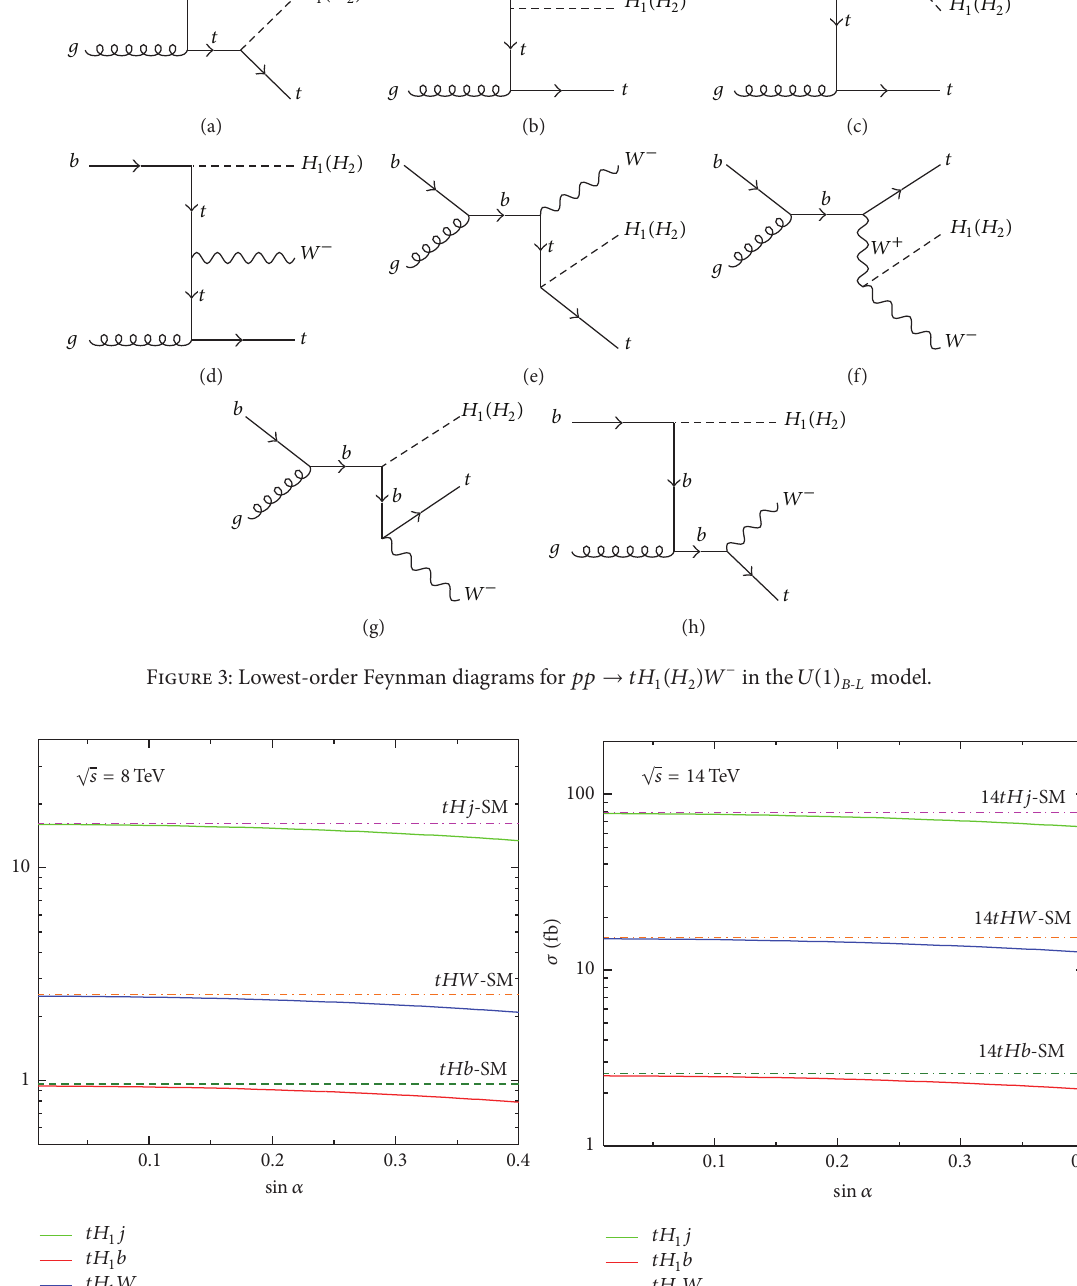
, 𝜎 𝑡𝐻 , 𝜎 𝑡𝐻 as a function of sin 𝛼 at 8, 14TeV LHC in the 𝑈(1) 𝐵 1 𝑗 1 𝑏 1 𝑊